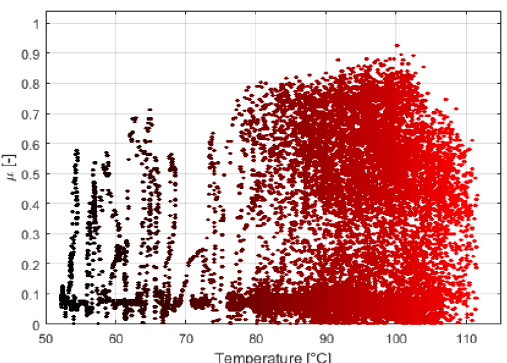
Figure 7. Tread core compound grip-temperature dependence.